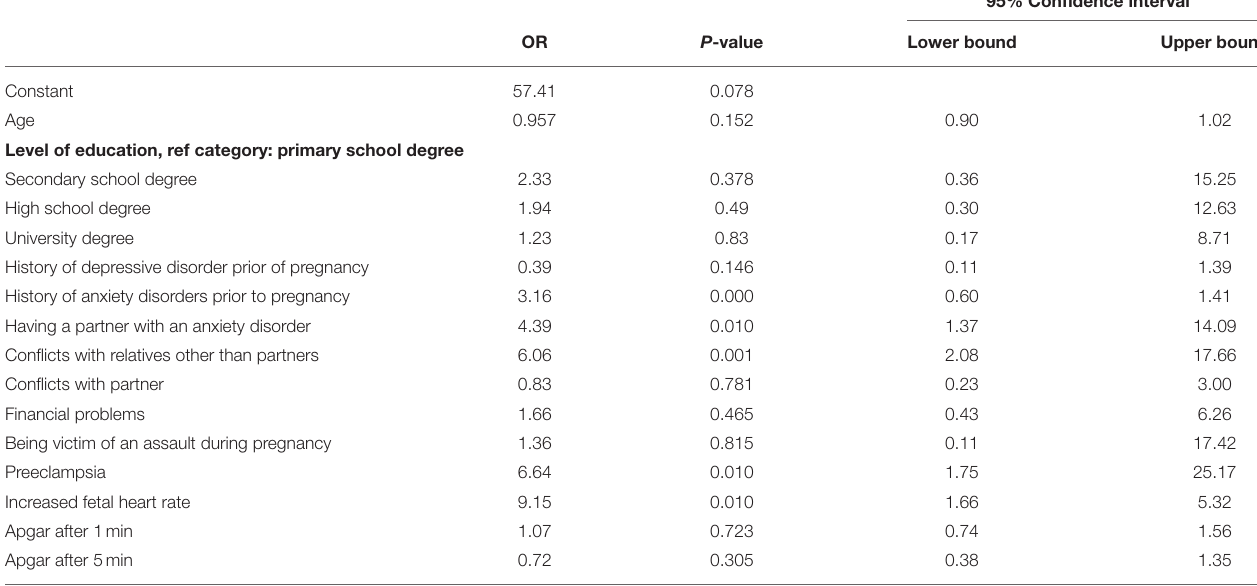
TABLE 2 | Predictors of Maternity Blues.